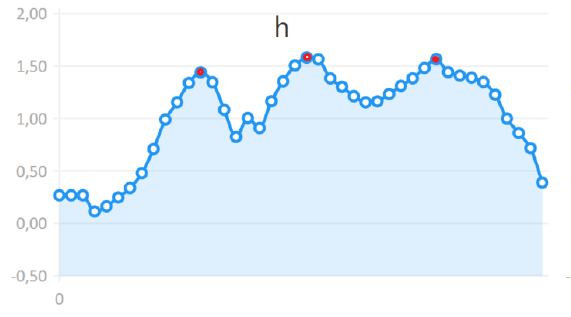
Figure 6. Red dots correspond to the peak vertical dimensions of anatomical occlusal surface on dentin.